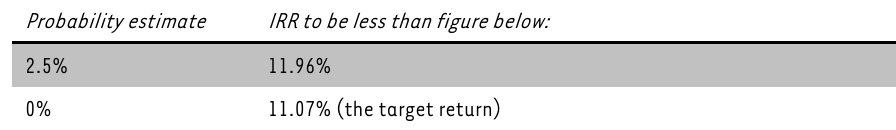
TABLE 9: Probabilities of downside IRR of the investments in Set C Probability estimate IRR to be less than figure